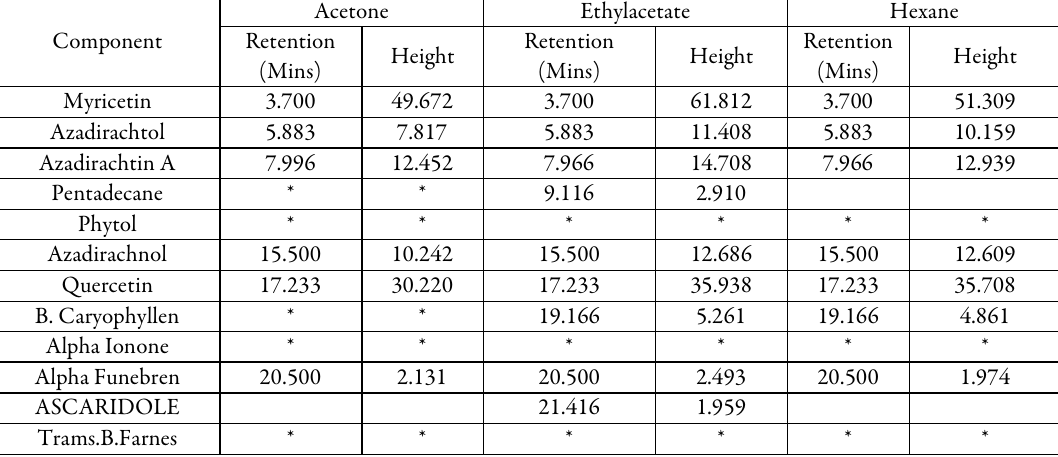
Table 2. Constituents of different solvent extracts of Azadirachta indica separated by HPLC Component